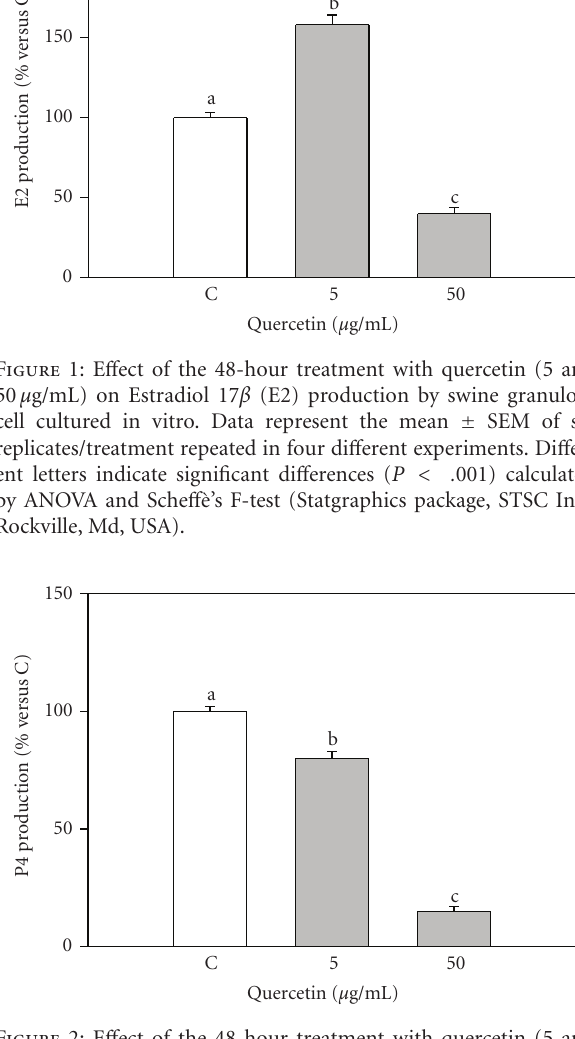
Figure 2: E ff ect of the 48-hour treatment with quercetin (5 and 50 μ g/mL) on progesterone (P4) production by swine granulosa cell cultured in vitro. Data represent the mean ± SEM of six replicates/treatment repeated in four di ff erent experiments. Di ff er- ent letters indicate significant di ff erences ( P < . 001) calculated by ANOVA and Sche ff `e’s F-test (Statgraphics package, STSC Inc., Rockville, Md, USA).